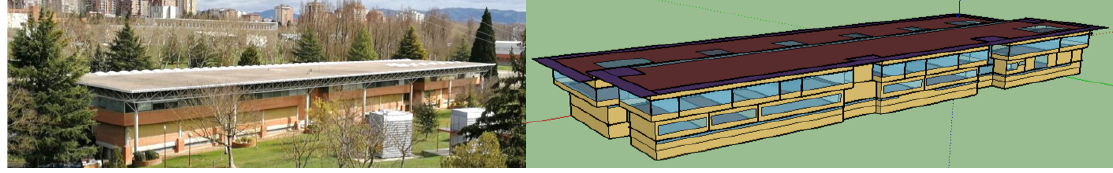
Figure 4. Real building vs.